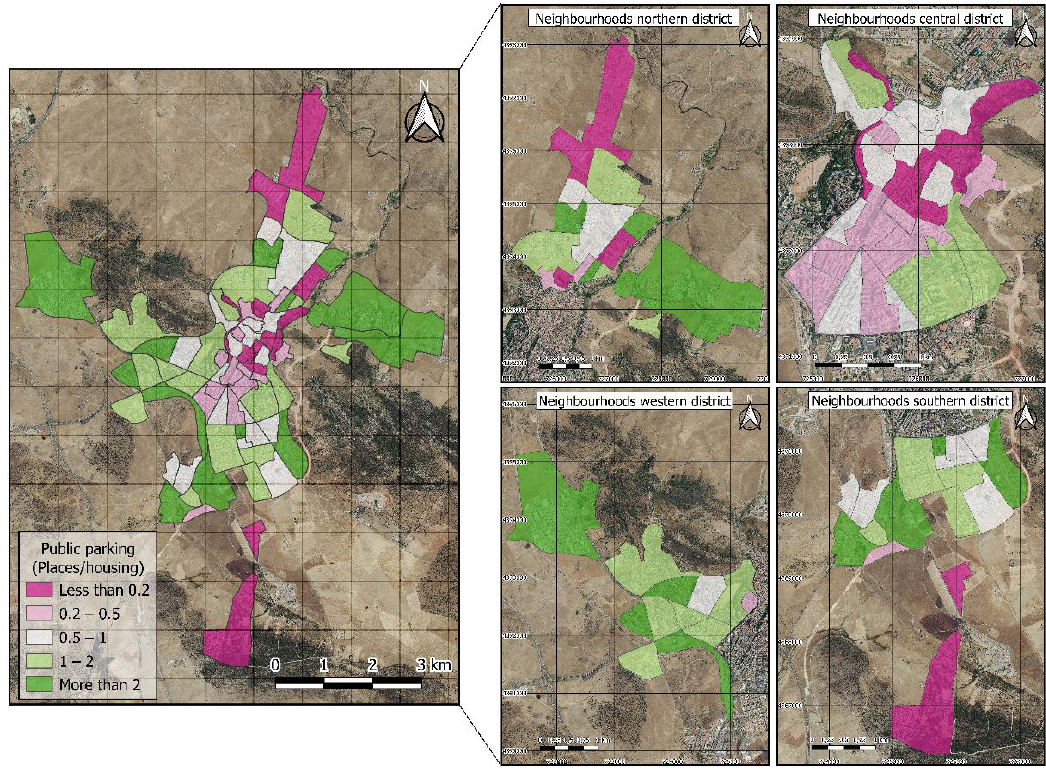
Figure 11. Public parking by